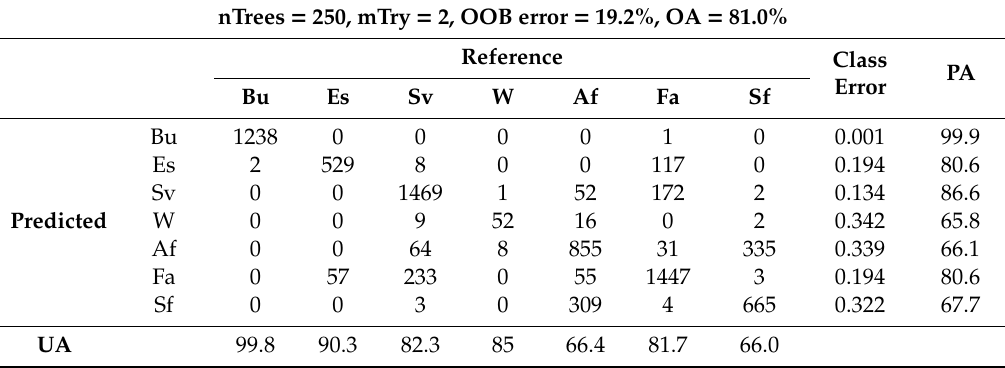
Table A3. The classification confusion matrix of the RE1